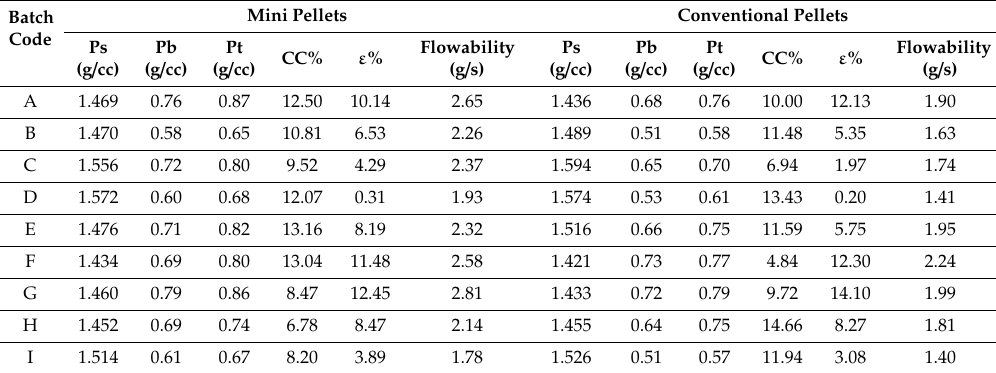
Table 4. Pycnometric densities, packing densities, packing index, porosity, and flowability of the experimental mini and conventional